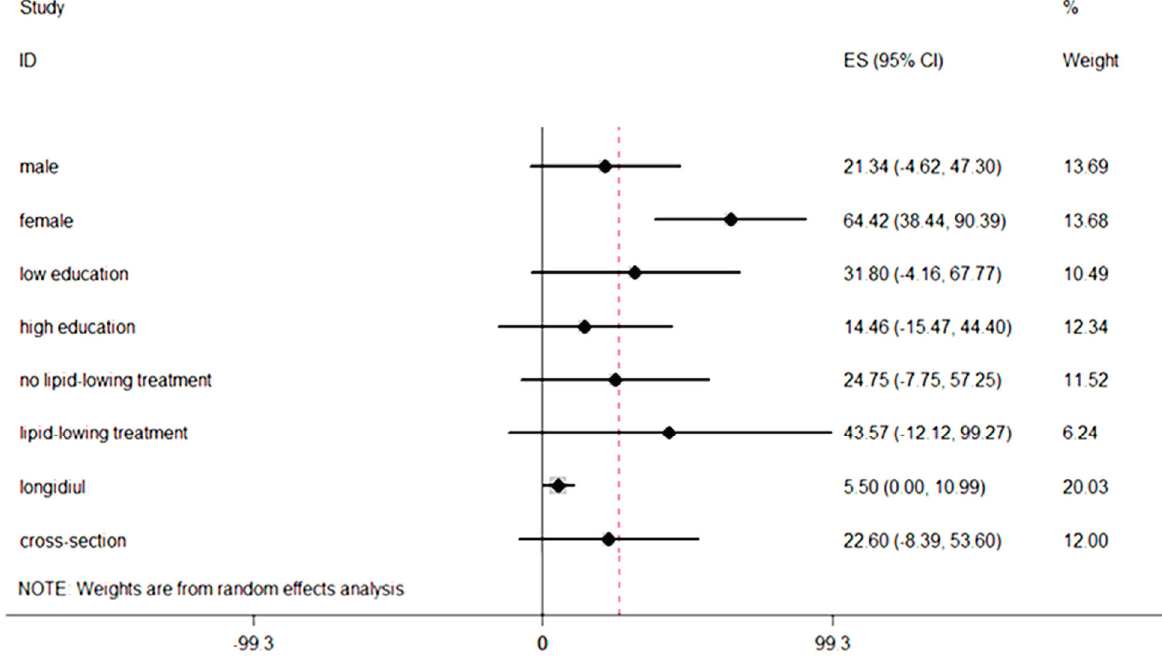
Figure 3. Subgroup analyses based on sex, education, treatment and study